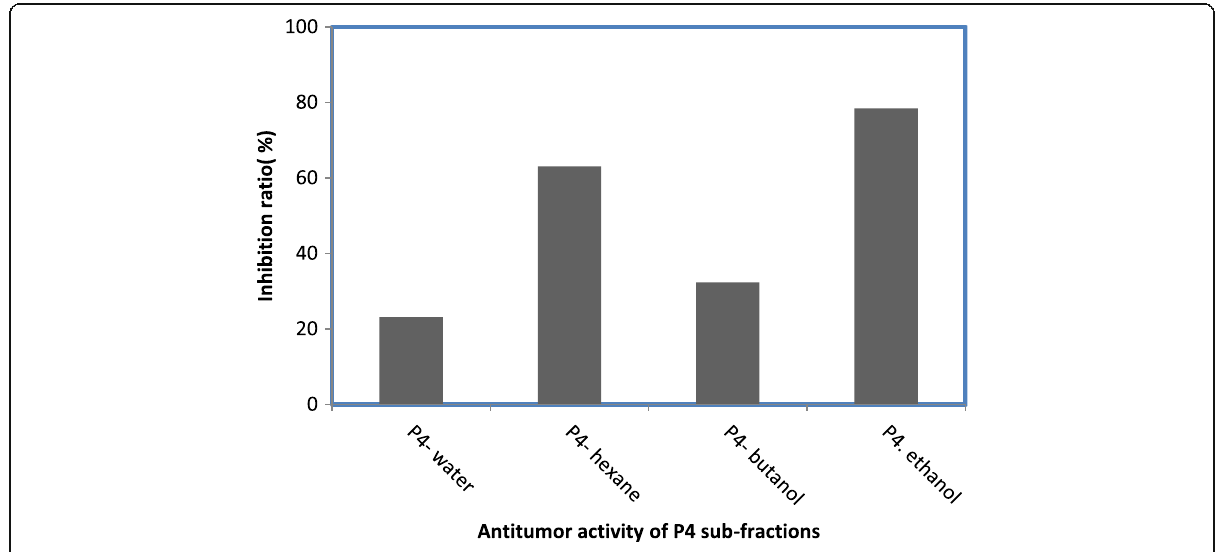
Fig. 6 Antitumor activity of Streptomyces sp. MER4 (P4) secondary metabolites fractionated from liquid-liquid partitioning